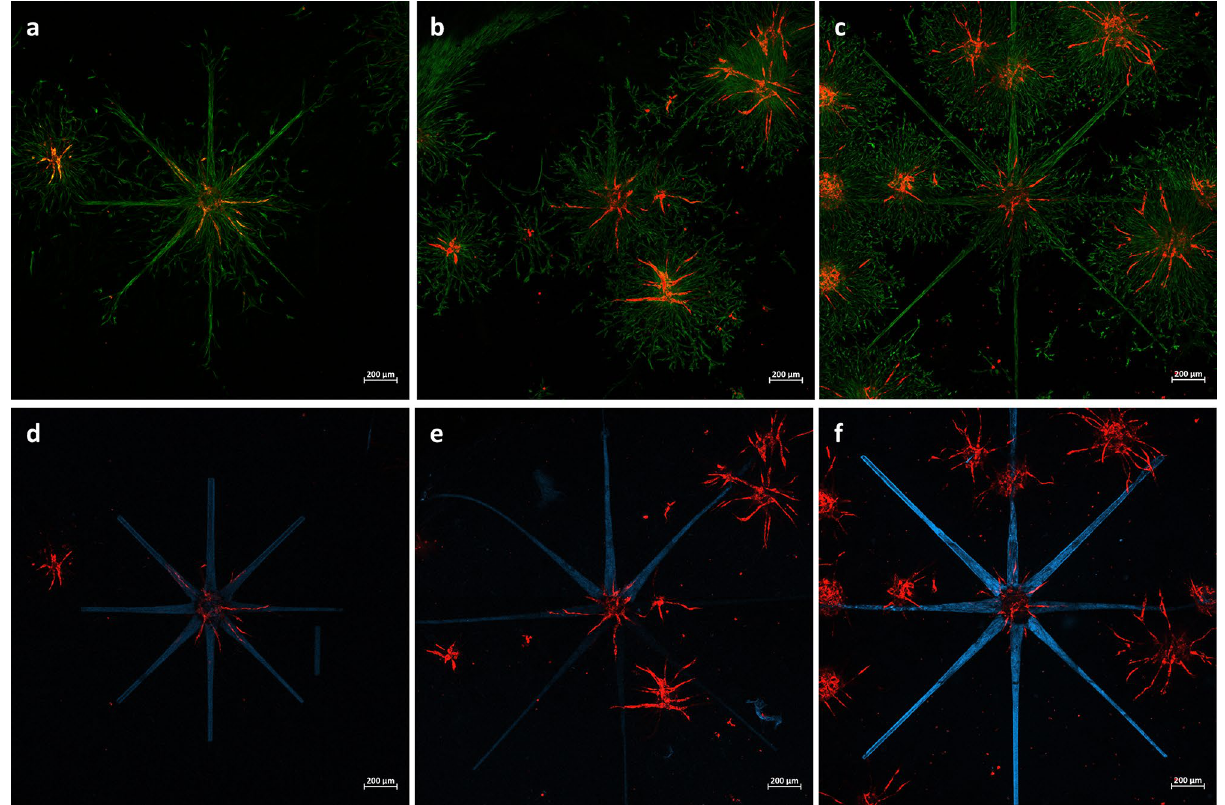
Figure 5. Laser scanning microscopy maximum intensity projection (MIP) images of RFP-HUVECs sprouting: Co-culture spheroids of GFP-hASCs and RFP-HUVECs in a 1 to 1 ratio, encapsulated in 5 wt% gel-MA DS 63. The photografted patterns are fluorescing in blue, the GFP-hASCs in green and the RFP-HUVECs in red. Every column displays the same sample, with the upper panel showing the green and red fluorescent channel to illustrate the dependence of sprouting on the positions of GFP-hASCs and in the lower panel the green and red fluorescent channels are displayed to illustrate the directional sprouting in accordance with the photografted structure. Images ( a,b,d and e ) have been taken on day 5, images ( c and f ) have been taken on day 3. The scale bars represent 500